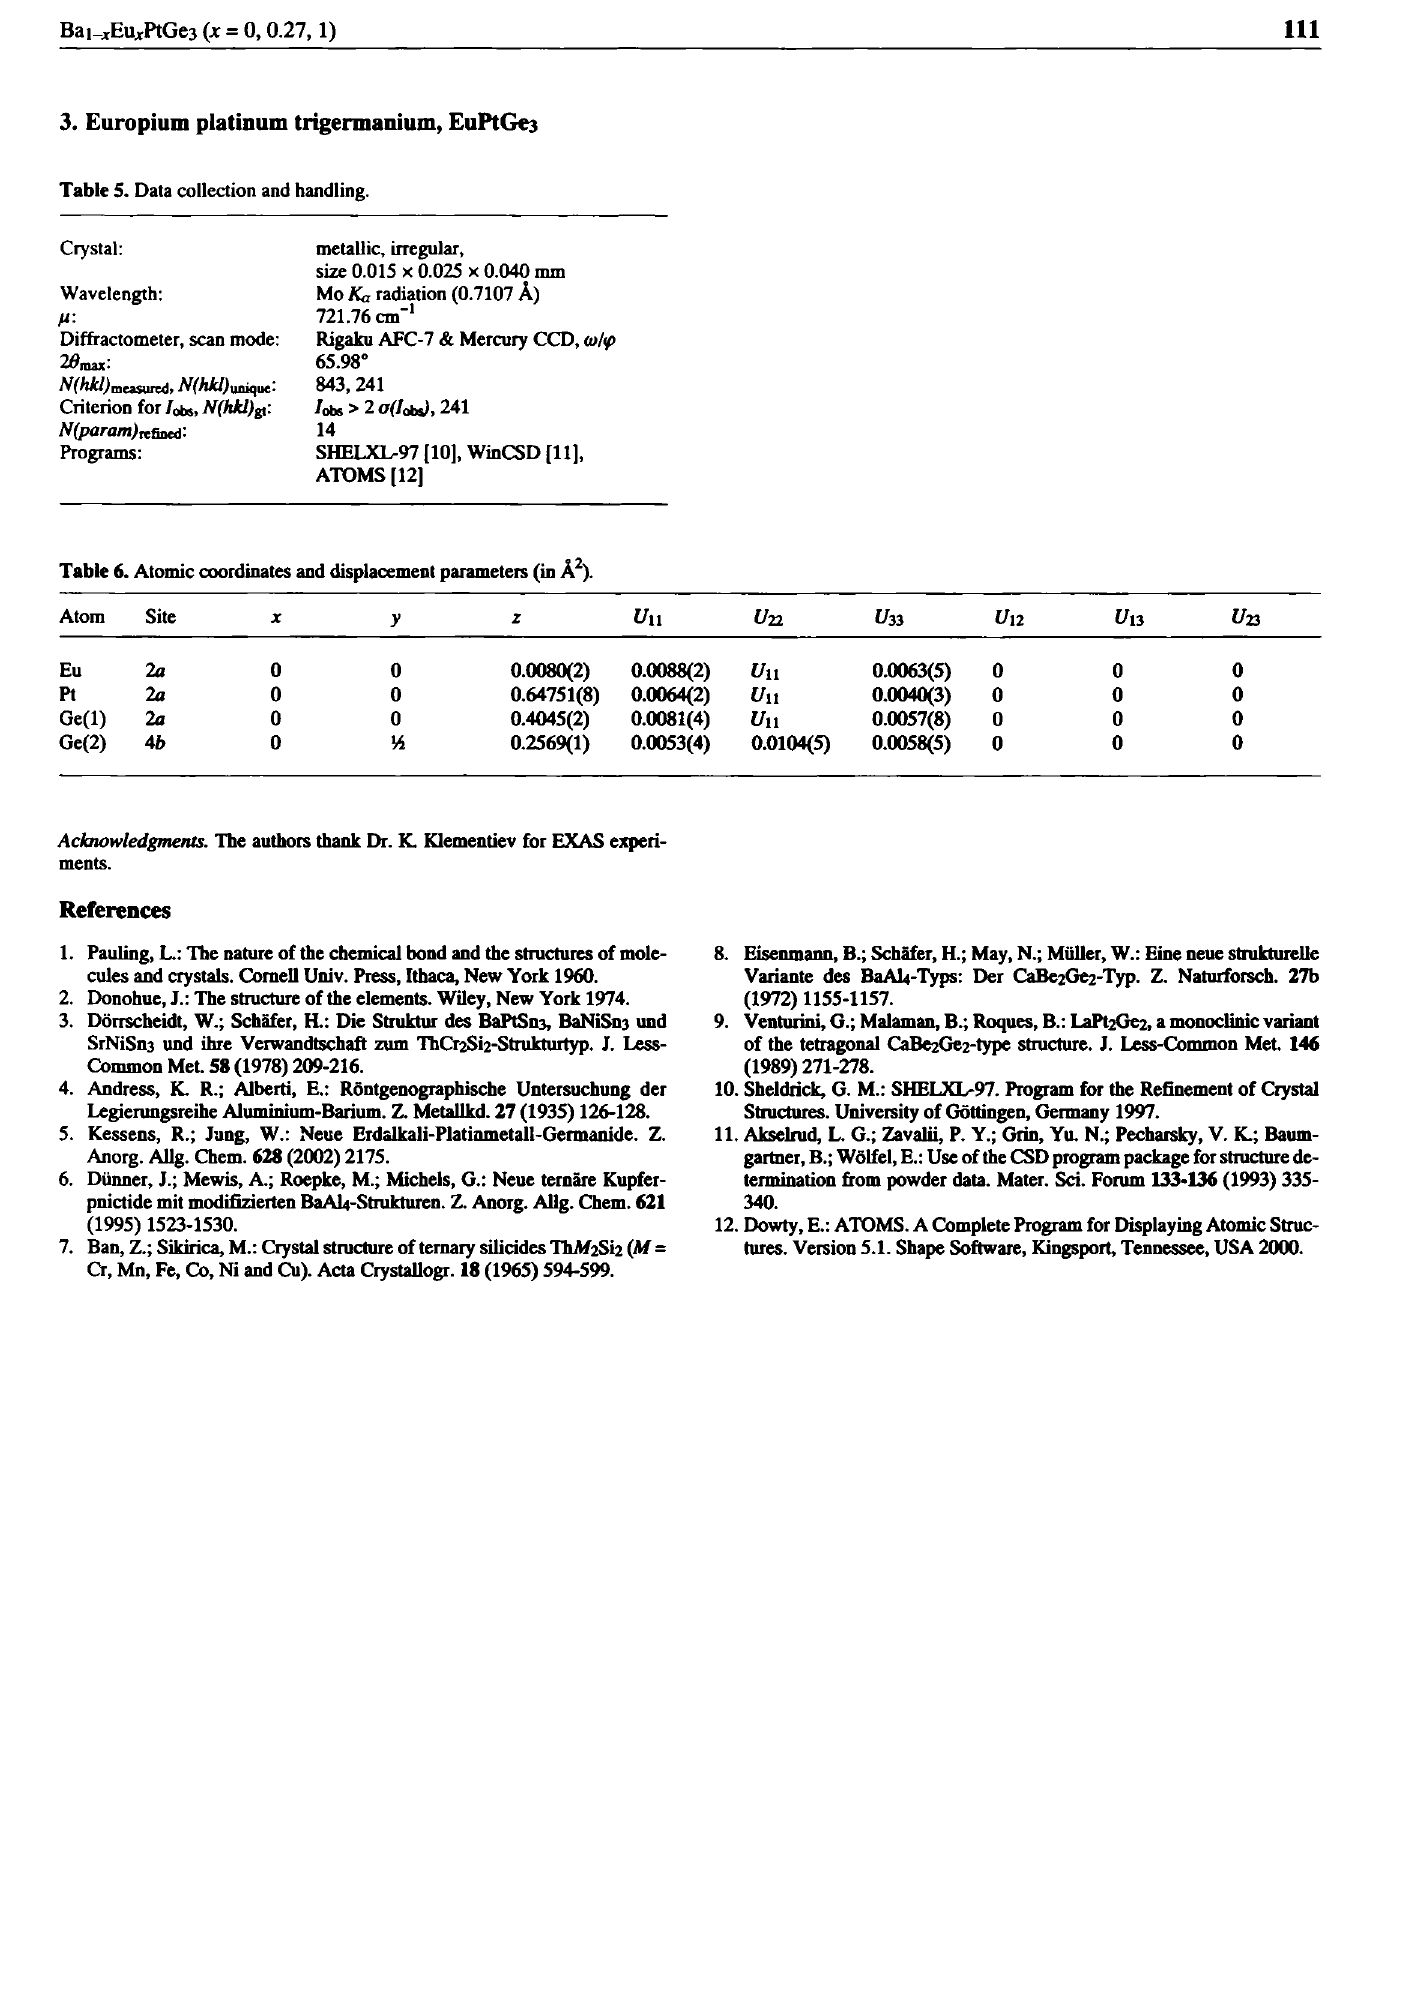
Table 5. Data collection and handling.